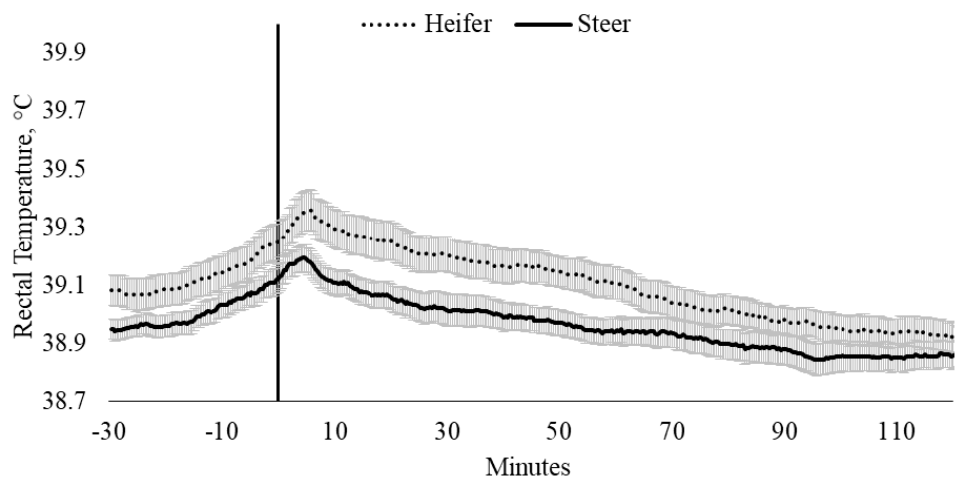
Figure 1. Twenty-seconds mean ( ± SEM) rectal temperature (T REC , ◦ C) of heifers (dotted line) and steers (solid line), 30 min prior to 2 h post-handling, also showing the time from weighing box (solid black vertical line).